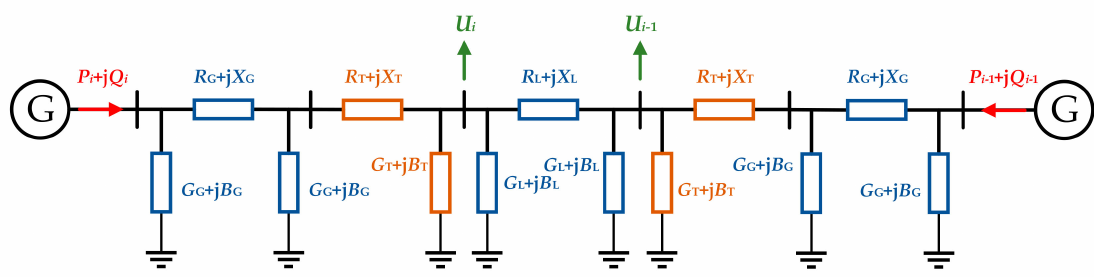
Figure 4. Equivalent circuit of adjacent wind turbines.